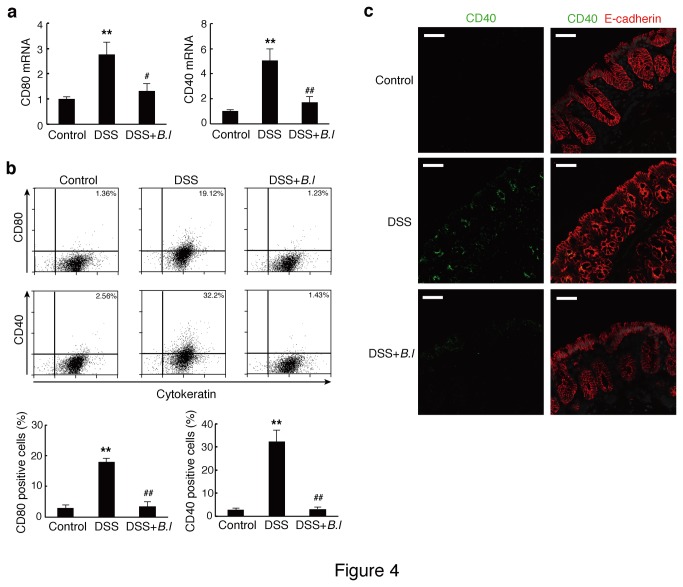
Oral treatment of B. longum JCM 1222T (B.l) suppresses the expression of costimulatory molecules in IEC.(a) mRNA expression of costimulatory molecules in IECs was analyzed by quantitative PCR. Levels of mRNA were normalized to β-actin mRNA, and expressed relative to control mice. The data are representative of three experiments. Results are expressed as means ± standard error (n = 6 (Control) or 7 (DSS, and DSS+B.l)). (b) IECs were stained for cytokeratin and CD80 or CD40 and analyzed by flow cytometry. Debris was gated out by forward and side scatter. Representative plots (upper panel) and the mean and standard error values of the percentage of cytokeratin/CD80 or CD40 positive cells (lower panel) are shown (n = 4). The data are representative of two experiments. (c) Cryosections of colonic tissue were labeled for CD40 (green) and E-cadherin (red). The data are representative of two experiments. Scale bars represent 50 μm. **
p<0.01 versus control mice (Control); #
p<0.05 and ##
p<0.01 versus DSS-treated mice (DSS).